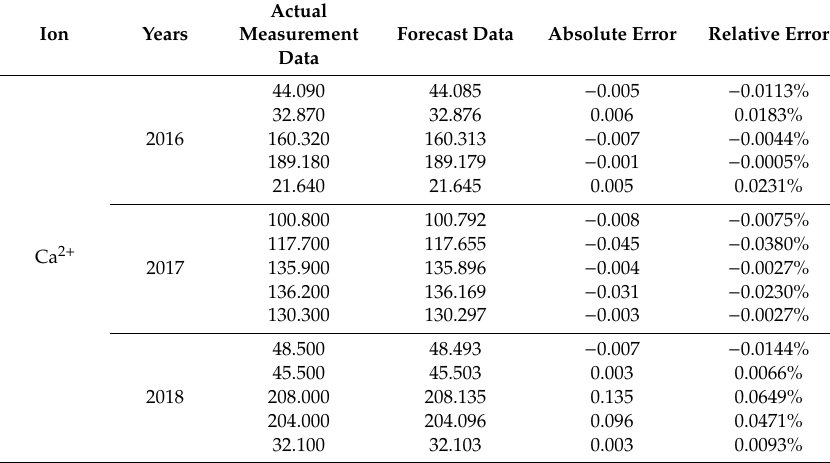
Table 4. List of predicted and actual